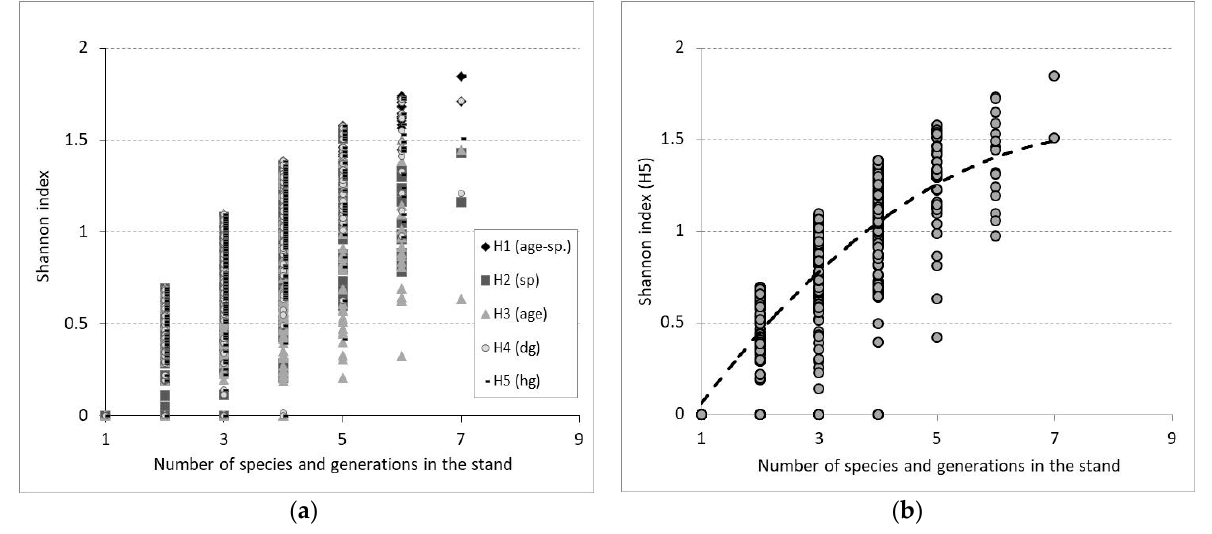
Figure 5. Shannon index calculated at the management unit level for ( a ) the stand characteristics (426 stands) and ( b ) the mean height of the stands.